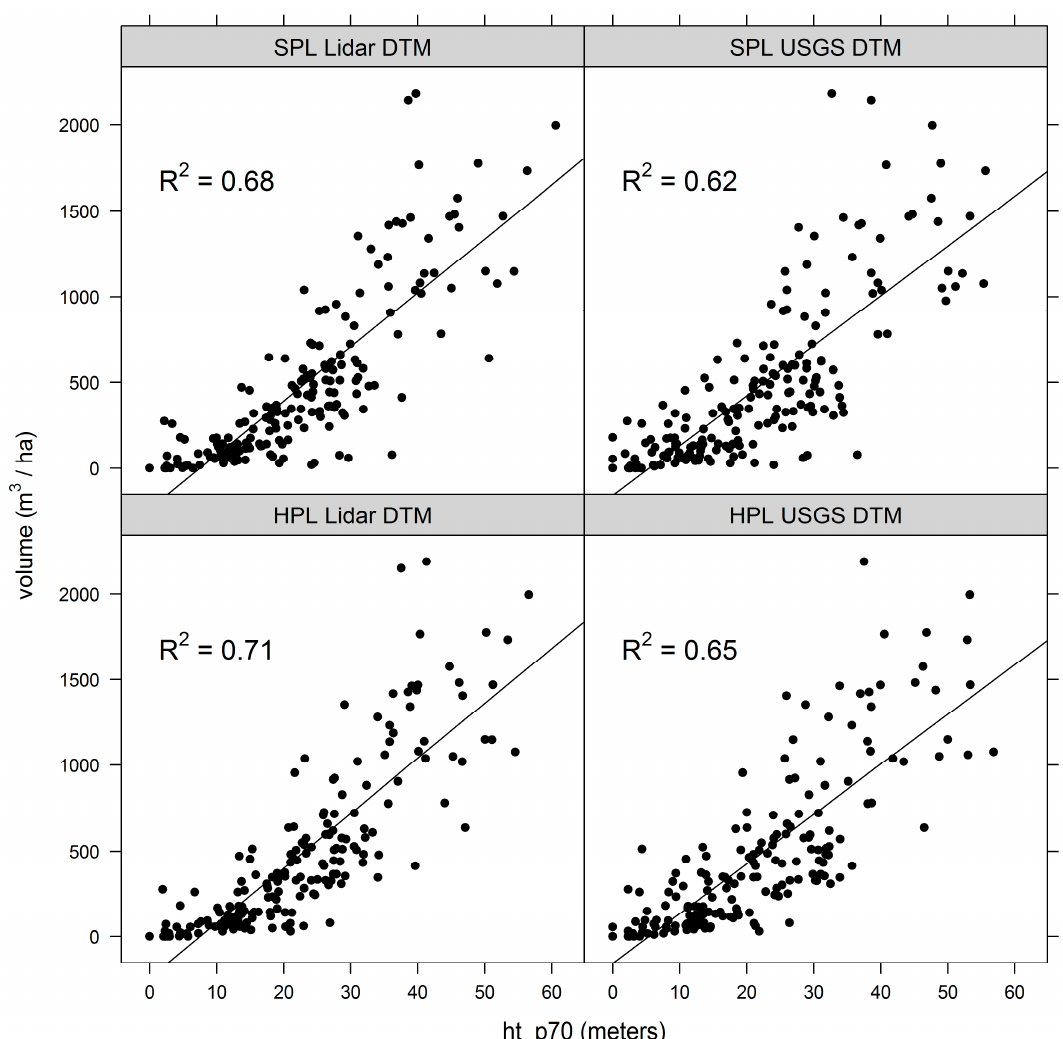
Figure 7. Scatterplots of ht_p70 relative to gross cubic volume for combinations of HPL and SPL with lidar and USGS DTMs overlaid on respective trend lines for a simple linear regression (OLS).